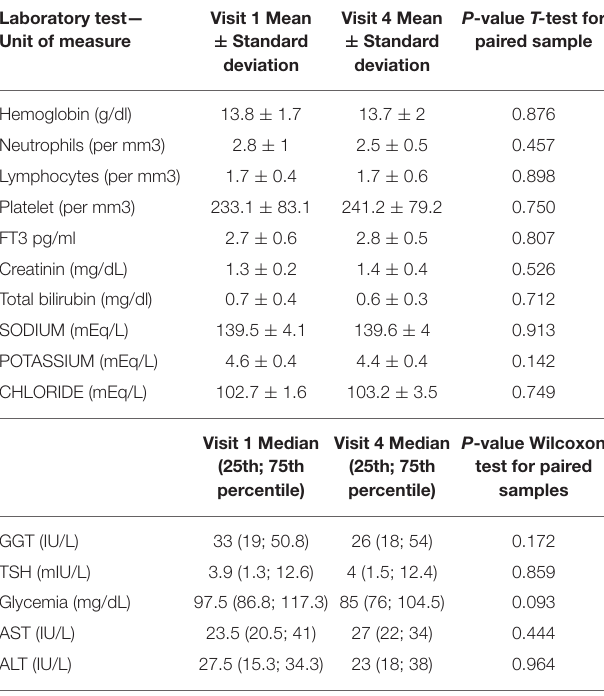
TABLE 4 | Concomitant medications during study P -value T- test for paired sample